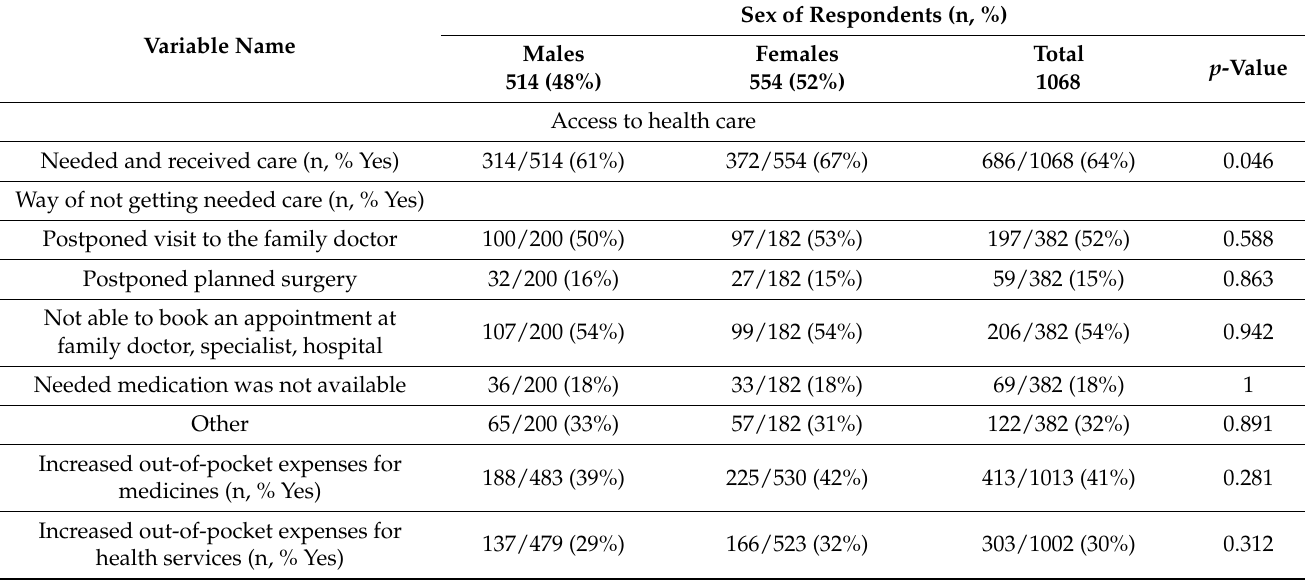
Table 1. Self-perceived access to care, postponements of care, and mental health in the adult popula- tion of Bosnia and Herzegovina during the COVID-19 pandemic by